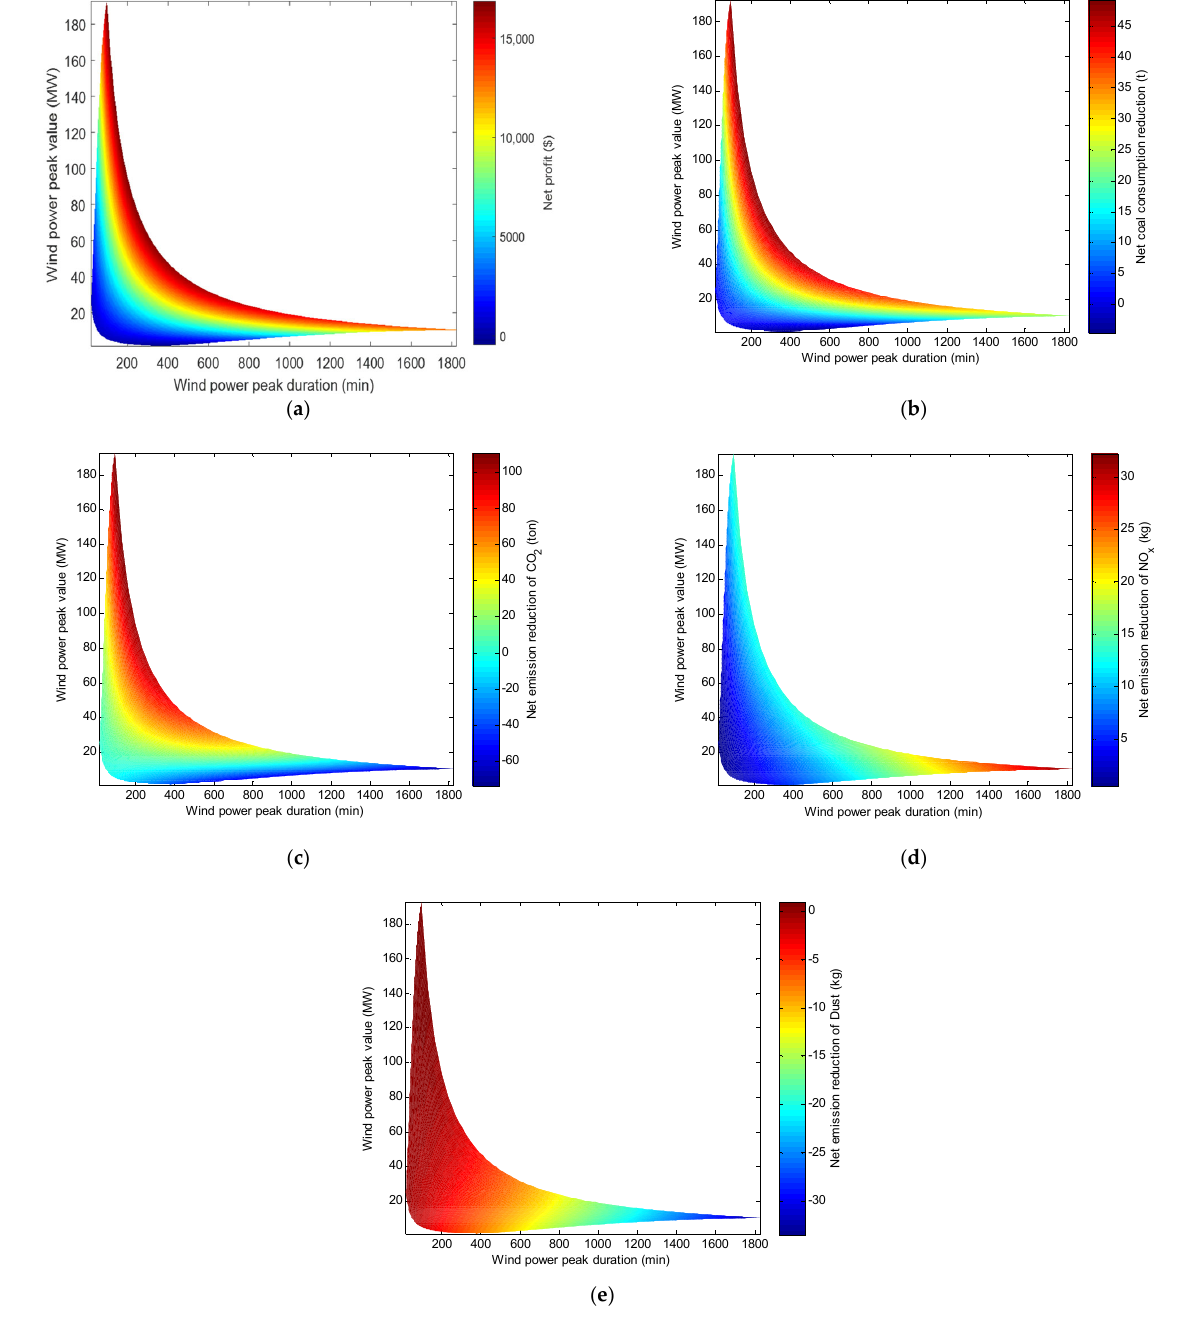
Figure 8. Net profit and net emission reduction of the wind–coal combined power generation system of strategy (2) against wind energy curtailment for wind power peaks above 240 MW. ( a ) Net profit; ( b ) Net coal consumption reduction; ( c ) Net emission reduction of CO 2 ; ( d ) Net emission reduction of NO x ; ( e ) Net emission reduction of dust. It can be seen that from the perspective of net profit, net coal saving, net CO 2 reduc ‐ tion and net NO x reduction, the wind energy curtailment boundary line is closer to the lower left, that is, the wind energy curtailment strategy should be adopted only when wind power peak duration T and peak height H are very small. This is because the 300